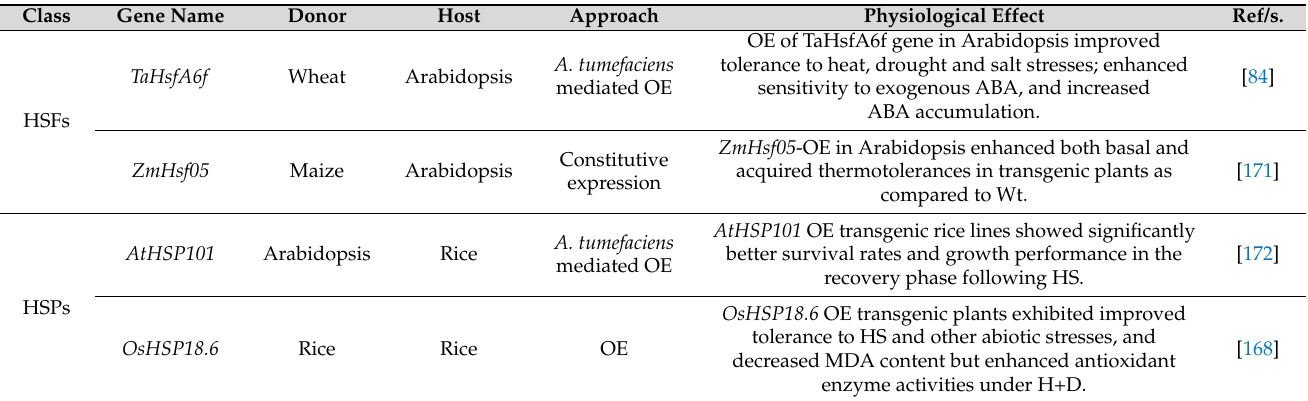
Table 2. Examples of heat-stress-tolerant genes verified by transgenic approaches that can be targeted for RSHS tolerance improvement in